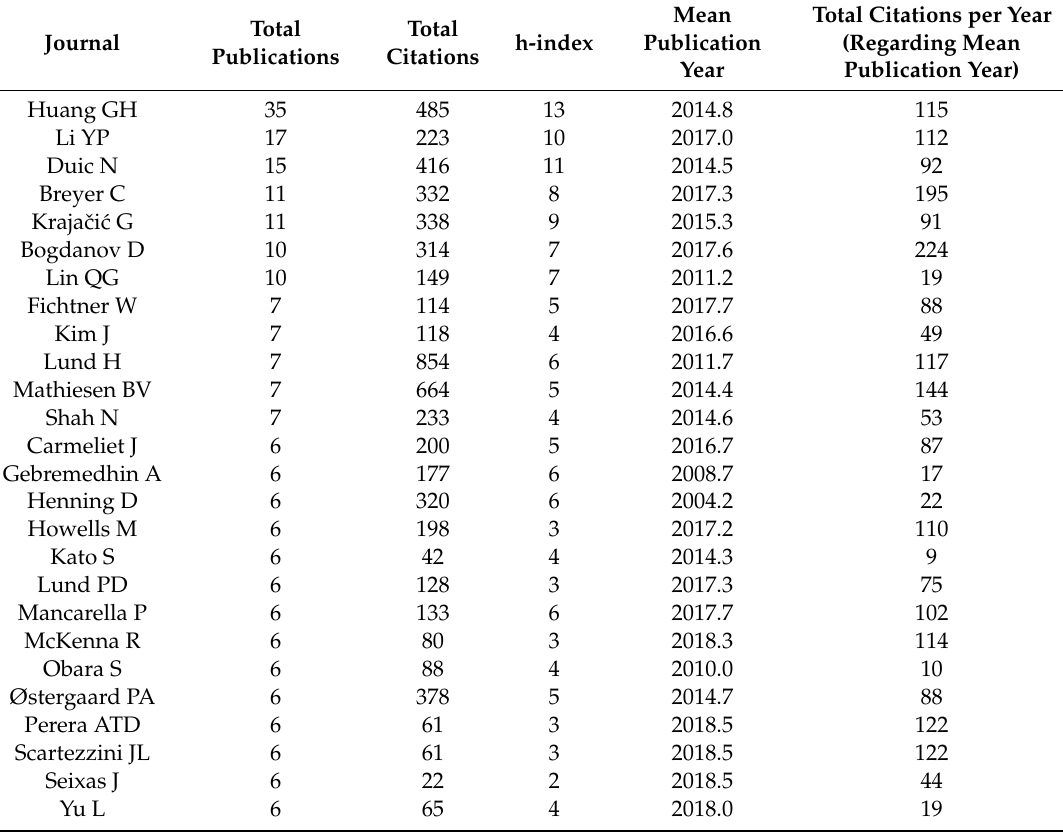
Table 6. The most productive authors in terms of publications on municipal energy system planning. Authors with at least six publications are